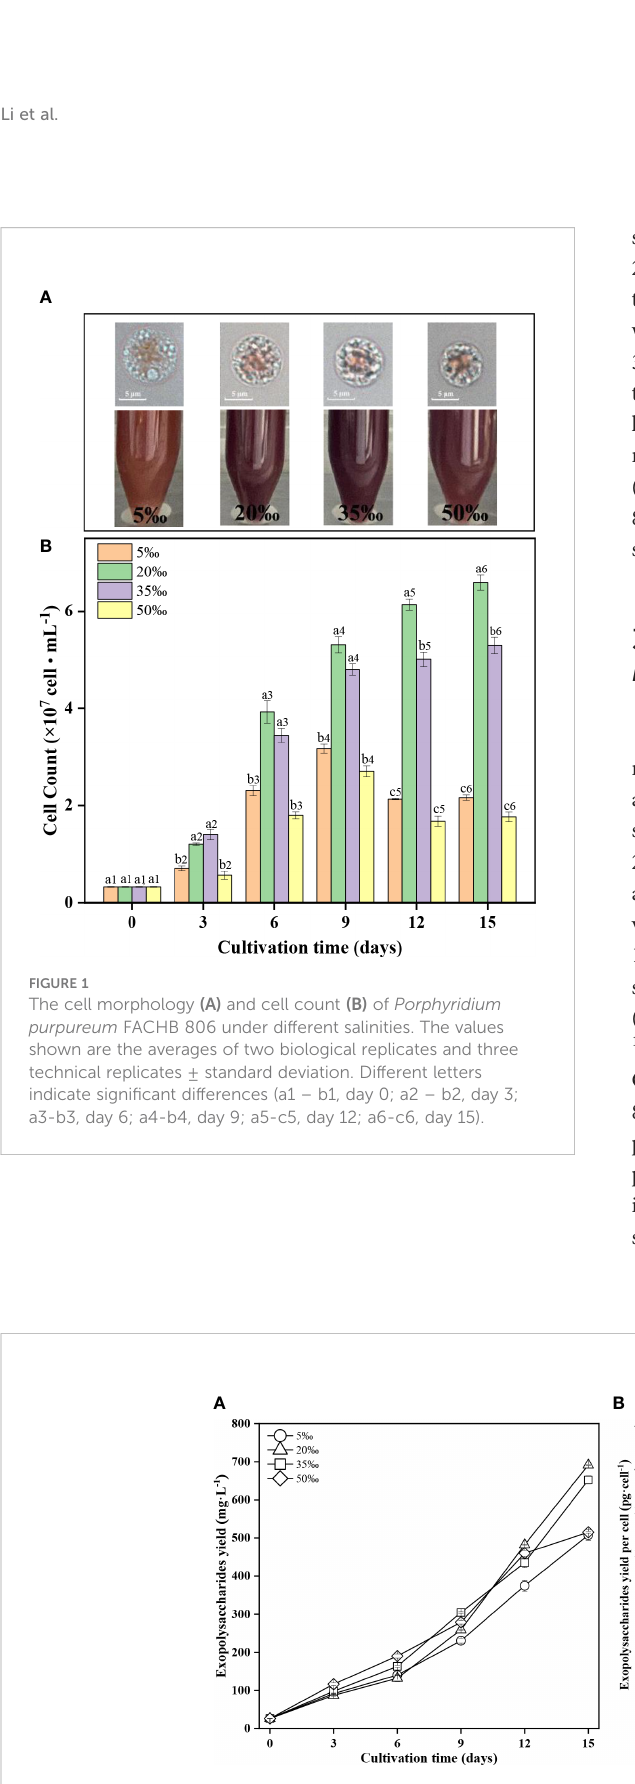
FIGURE 2 Exopolysaccharide yield (A) and exopolysaccharide yield per cell (B) of Porphyridium purpureum FACHB 806 under different salinities. The values shown are the averages of two biological replicates and three technical replicates ± standard